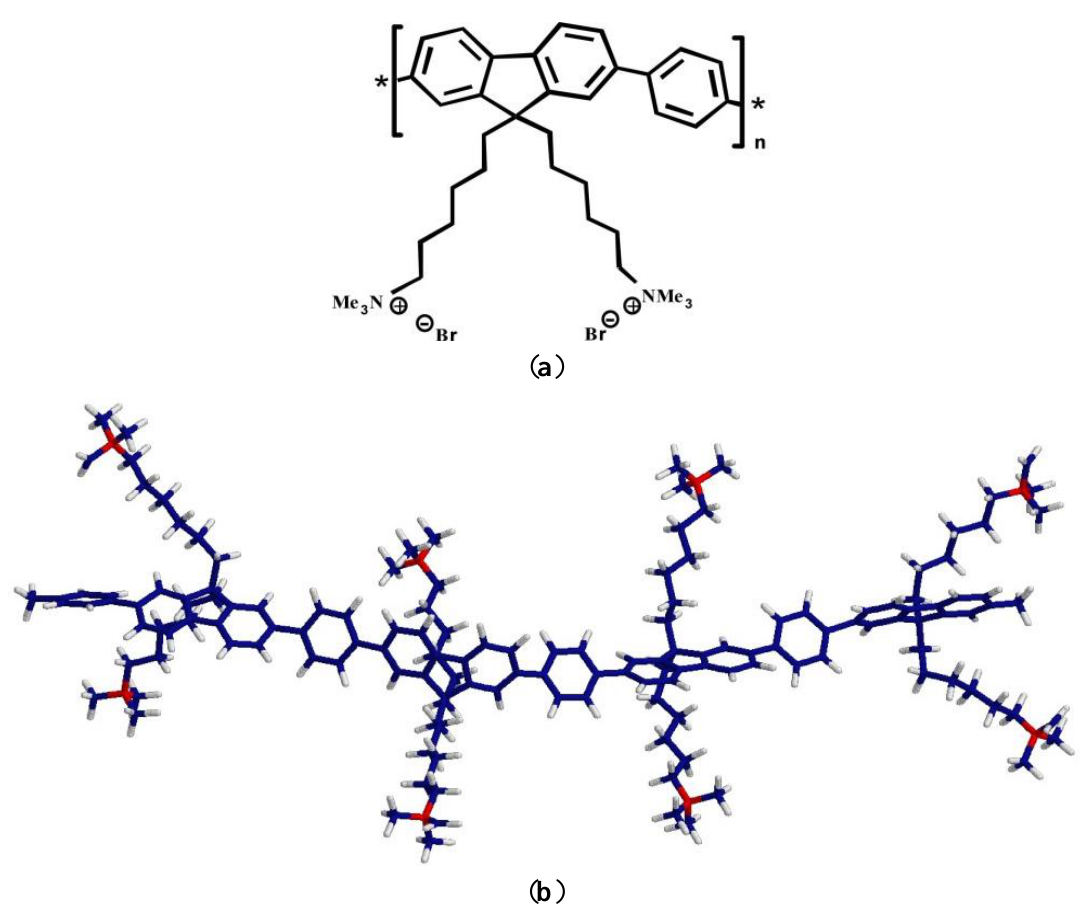
Figure 1. ( a ) HTMA-PFP chemical structure; ( b ) the conformation of a tetramer of HTMA-PFP obtained using molecular dynamics